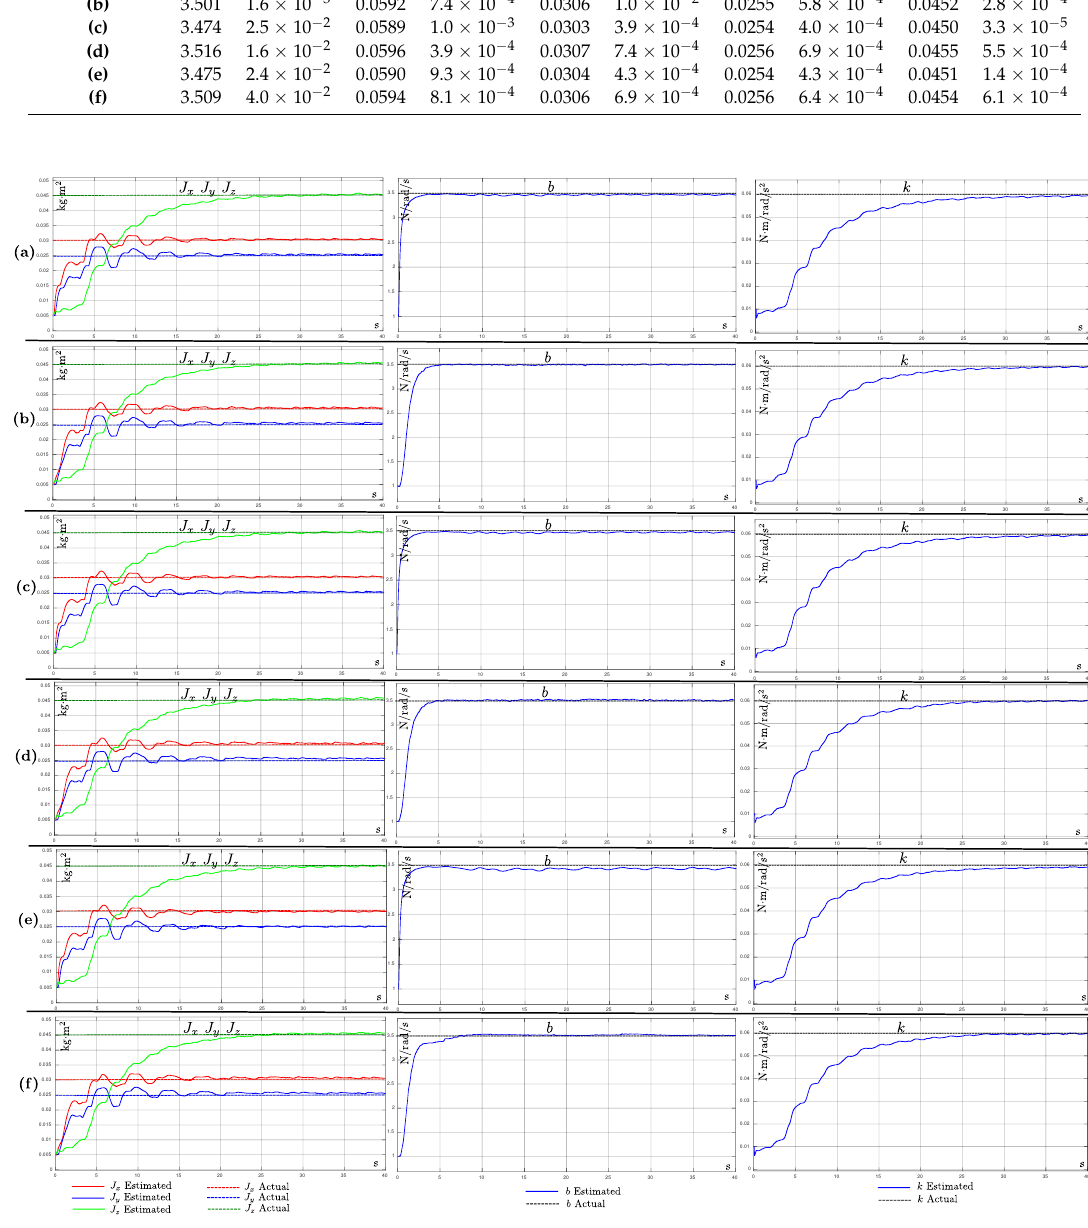
Figure 5. Estimates of the model parameters values ( J x , J y , J z , b , k ) obtained from each sensor configurations ( a – f ). Each row of plots shows the results of a different sensor